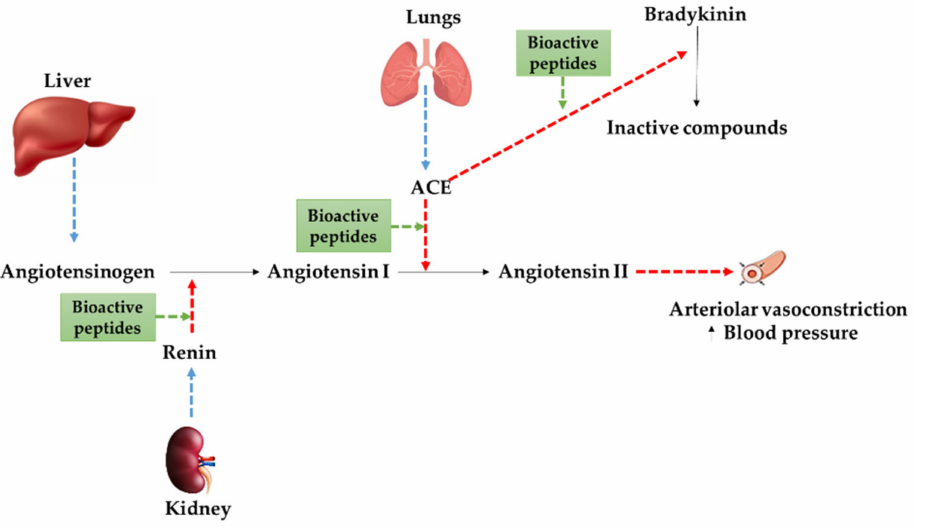
Figure 1. Potential mechanisms for the cardioprotective effects of bioactive peptides derived from